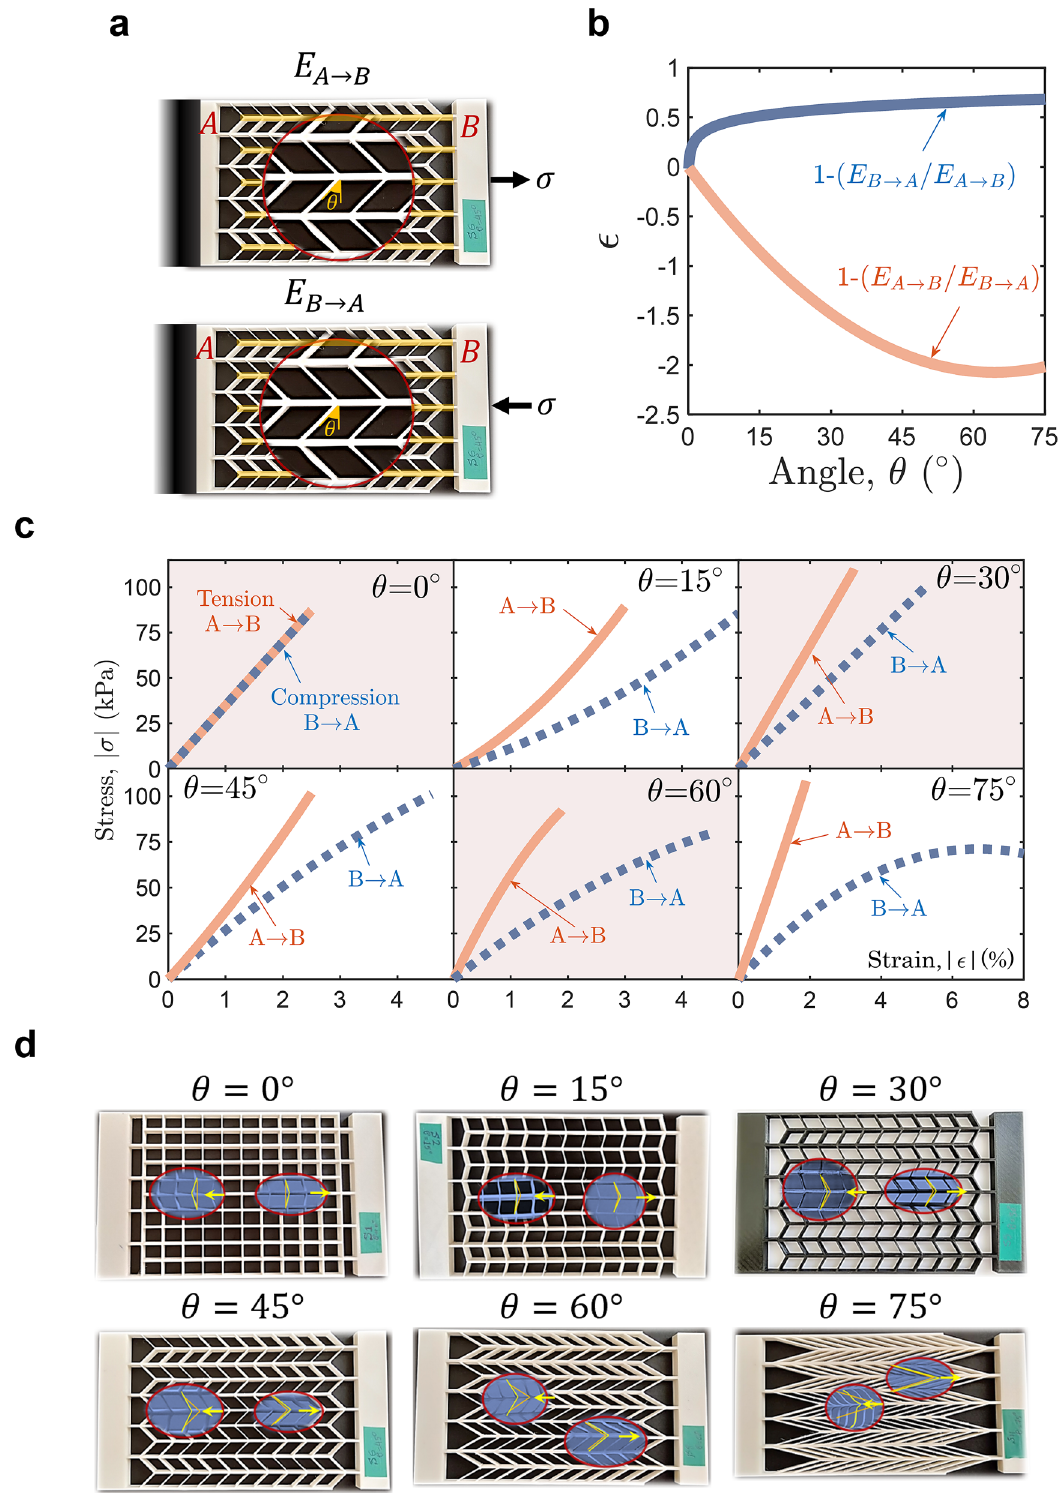
Figure 3. Metamaterials with nonreciprocal linear and nonlinear elasticities. ( a ) One sample of the developed 45 metamaterial with a geometrical angle θ ◦ . The material sample is tested under tension and compression such that = it is fixed at side A and loaded from side B. Under the tensile test, the tensile load is applied on the highlighted ribs, which B . Under the compression test, the compressive load is applied on the same ribs, which are are pulled to the right, A → A . ( b ) The nonreciprocal elasticity parameter ǫ versus the geometrical angle θ (experimental pushed to the left, B → B ) and compression tests ( B A ) of the 3D printed results). ( c ) The elastic stress–strain curves of the tensile tests ( A → → 0 , 15 , 30 , 45 , 60 , 75 material samples with different geometrical angles θ ◦ ◦ ◦ ◦ ◦ ◦ . ( d ) Images of the 3D printed material = samples. The insets show the asymmetric deformations of the material under tension and